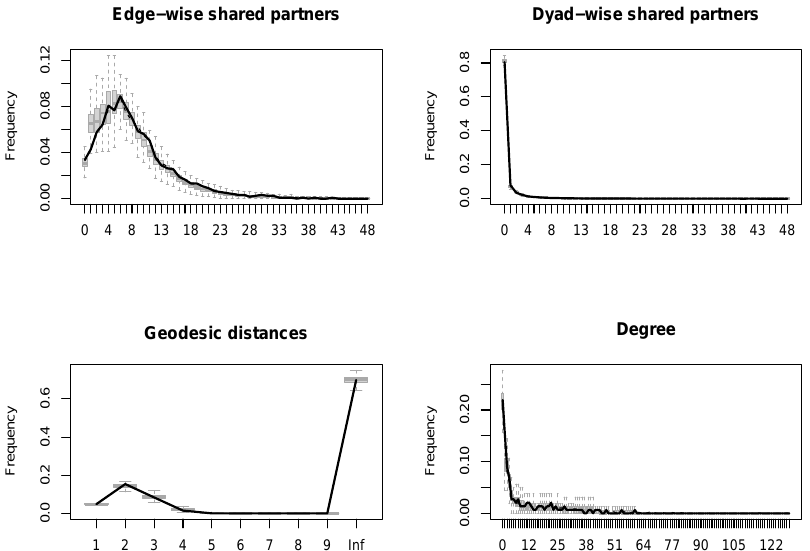
Figure 4. The GOF assessment of TERGM for VWSR transfer networks (Model 3). The solid black line in the figure indicates the observed statistical characteristics of the VWSR transmission network, and the box plot indicates the structural characteristics of the network based on the model